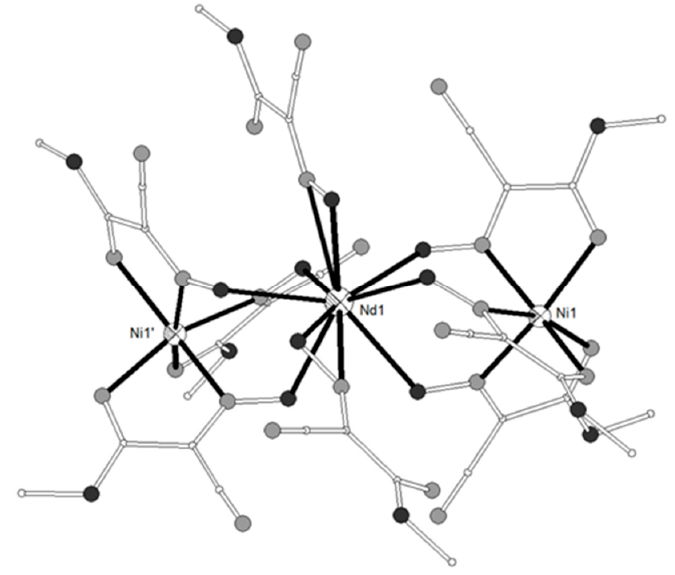
Figure 12. The molecular structure of the anion [{(Ni(L 23 ) 3 } 2 Nd(L 23 ) 2 ] − in complex 105 . Primed atoms are generated by symmetry: (‘) 1/3 + y , − 1/3 + x , 1/6 − z . Color code as in Figure 2 [44].